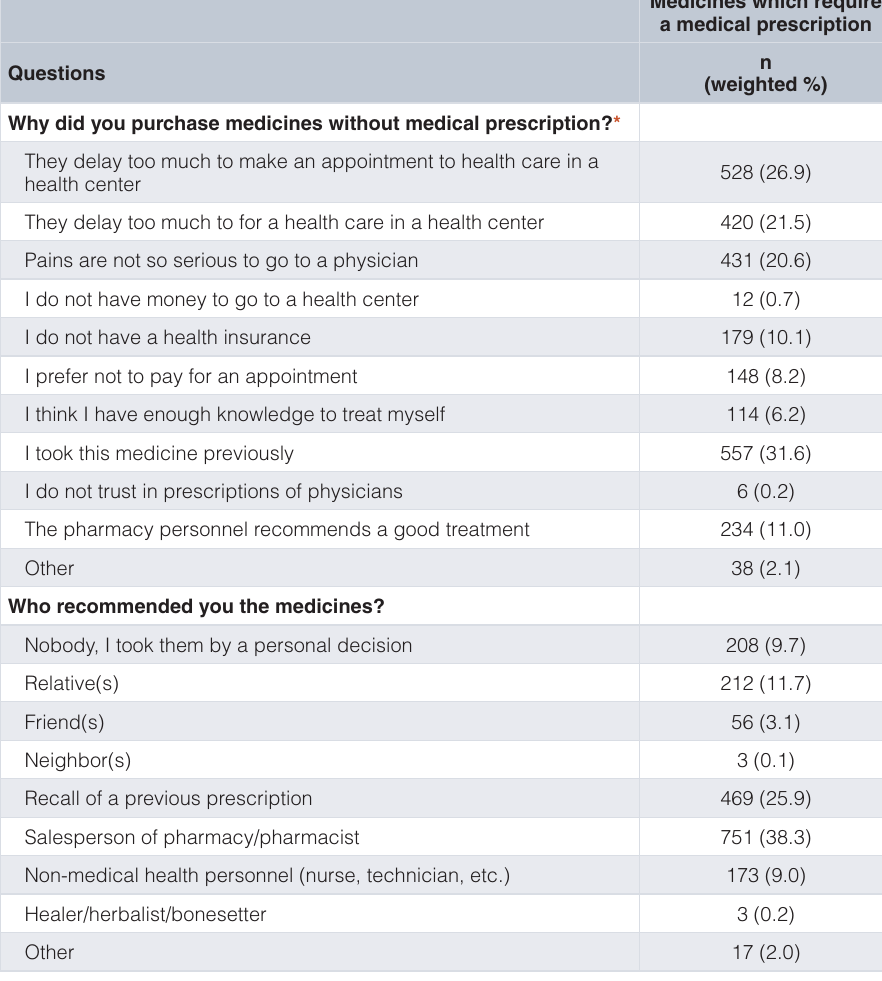
Table 2. Reasons of purchase and responsible individuals of the recommendation to purchase medicines which require medical prescription in Peru without prescription, Encuesta Nacional de Satisfacción de Usuarios en Salud (ENSUSALUD) 2016